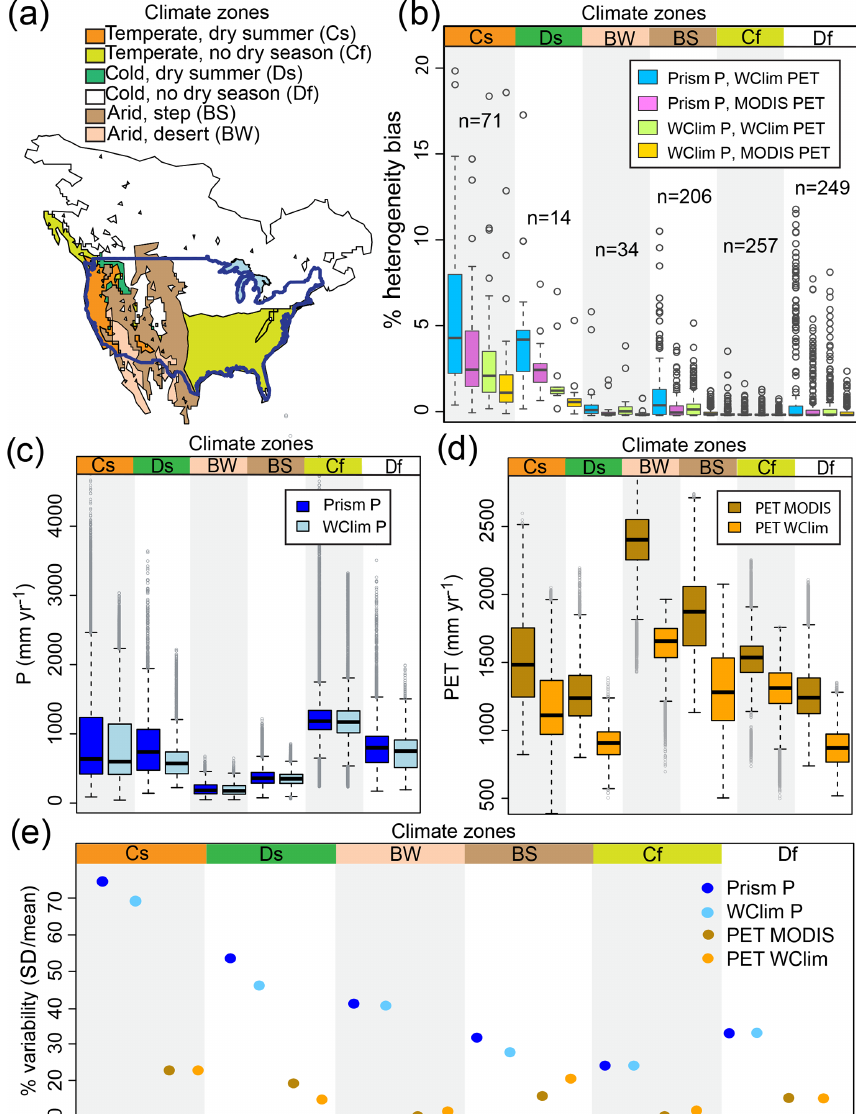
Figure 5. (a) Köppen–Geiger climate classification (Peel et al., 2007 in Beck et al. 2013) across the contiguous US; (b) the distribution of calculated heterogeneity bias in ET estimates (Eq. 4) at a 1 ◦ × 1 ◦ grid cell in individual climate zones, shown by boxplot (three data points with heterogeneity biases of over 20% are off-scale). The significance of differences between the pairs are presented in Table S1. Panels (c) and (d) show the distribution of precipitation products (Prism and WorldClim) and potential evaporation products (MODIS and WorldClim) at individual climate zones, respectively. The color-coded climate zones at the tops of panels (b–d) correspond to the climate zones mapped in panel (a) . Panel (e) compares the percentage variability of the two P and PET data products across climate zones, showing that the percentage variability in P is markedly higher than in PET, and the percentage variability in Prism P is somewhat higher than in WorldClim P, particularly in climate zones with dry summers. WClim: